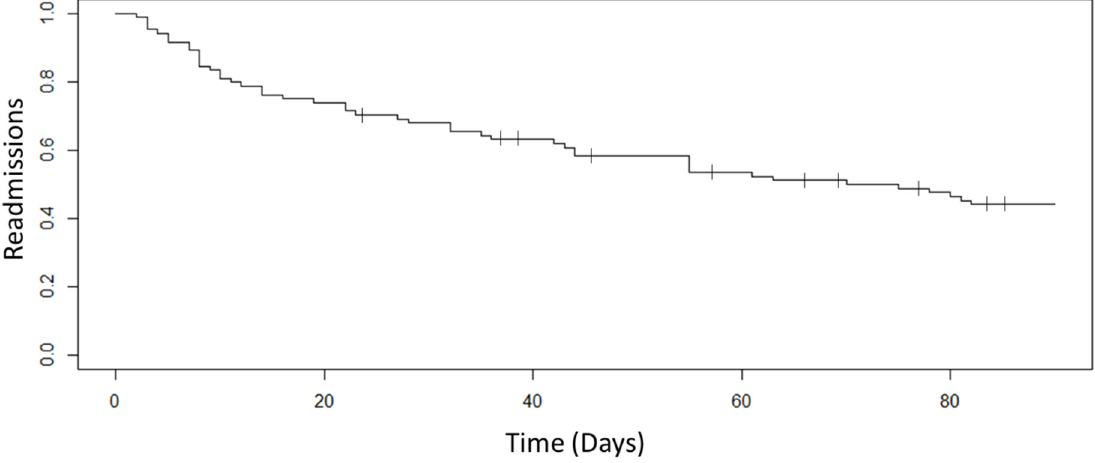
Figure 2. Kaplan–Meier curve for 3-month readmissions of the 84 participants, with censoring provided for the 10 patients who passed away.